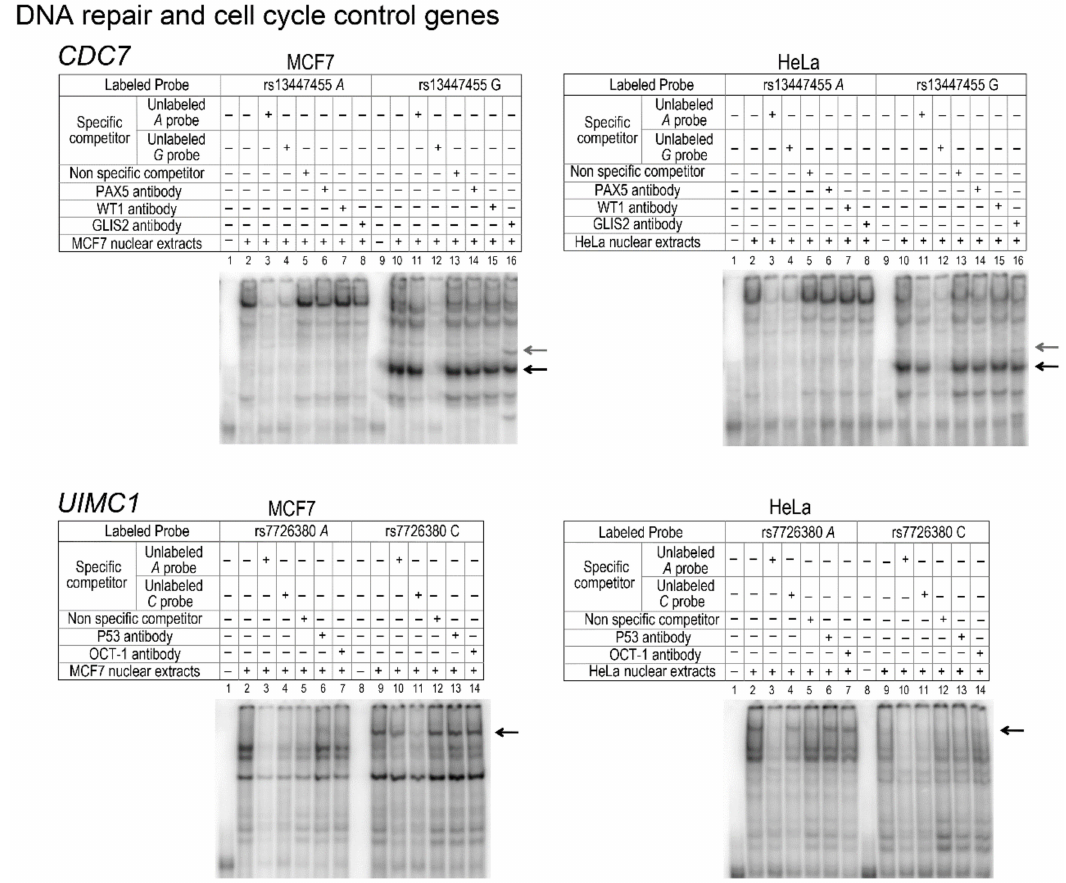
Figure 4. Representative EMSA analysis showing DNA–protein interactions in the promoter region of the selected genes involved in DNA repair and cell cycle control. CDC7 and UIMC as genes involved in DNA repair and cell cycle control pathways. Labeled double-stranded oligonucleotide probes for each of the respective variants tested were incubated with nuclear extracts from MCF7 and HeLa cells. The unlabeled probes used to determine non-specific radioisotope binding (at a 50-fold molar excess) are indicated for each lane. Specific competitors corresponding to the unlabeled allele-specific probes and a non-specific double-stranded oligonucleotide competitor were used for each experiment. Fast-migrating unbound probes are found at the bottom of the gel whereas protein–DNA complexes formed display a slower mobility. Black arrows indicate probe-specific differential protein binding. Bands containing antibody-protein-DNA complexes are highlighted by grey arrows. The Protein Atlas (https://www.proteinatlas.org) and ProteomicsDB (https://www.proteomicsdb.org) databases report protein expression data for GLIS2, Oct-1 in HeLa cells, and p53, Oct-1 in MCF7. No expression data was available for Paired Box 5 (PAX5) or Wilms Tumor 1(WT1) transcription factors in either cell